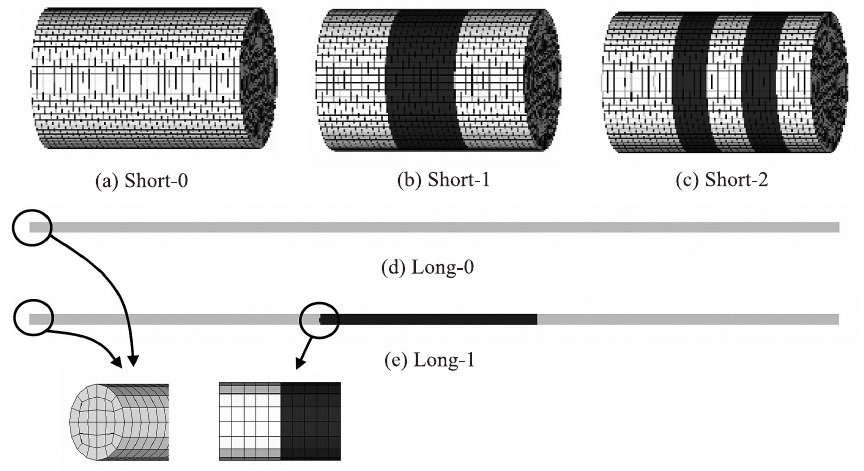
Fig. 4. Simulation models of the short ( fi gures a, b and c) and long ( fi gures d and e) cylindrical structures. Different shades represent different materials; (a) a short structure made of aluminum only (b) a short structure made of aluminum and one layer of polycarbonate at the middle